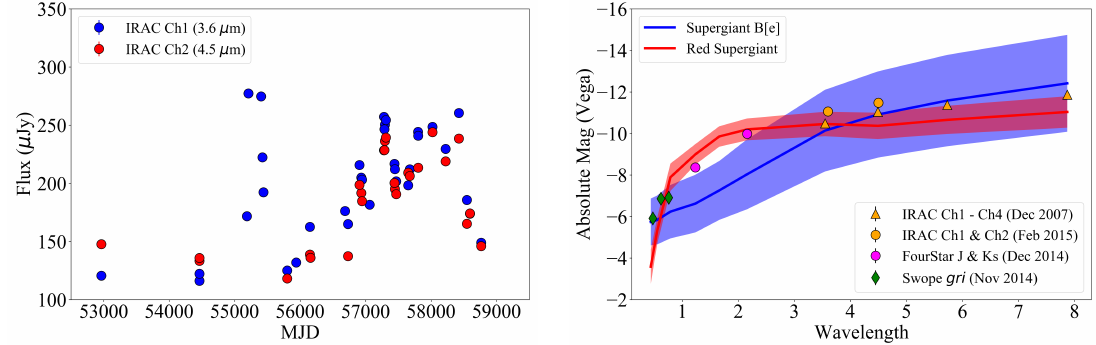
Figure 8. ( Left ) Spitzer /IRAC mid-IR light curve of SN 2010da/NGC 300 ULX-1 from 2004–2019. The red and blue points correspond to photometry measured at 3.6 µ m and 4.5 µ m, respectively. Only 3.6 µ m observations were serendipitously obtained near the 2010 outburst. ( Right ) Spectral energy distribution (SED) of SN 2010da/NGC 300 ULX-1 during pre-outburst (December 2007) and post-outburst phases (late 2014/early 2015) overlaid on SED templates of 122 RSG and 11 sgB[e] stars in the Large Magellanic Cloud, cataloged by Bonanos et al. [55]. Solid lines correspond to the median VIJHKs and Spitzer /IRAC magnitudes of the SED template stars, and the surrounding shaded regions indicate the 1 σ spread in the magnitudes of the distribution. The wavelength on the x -axis is shown in units of µ m. Both figures are reproduced and modified from Lau et al.